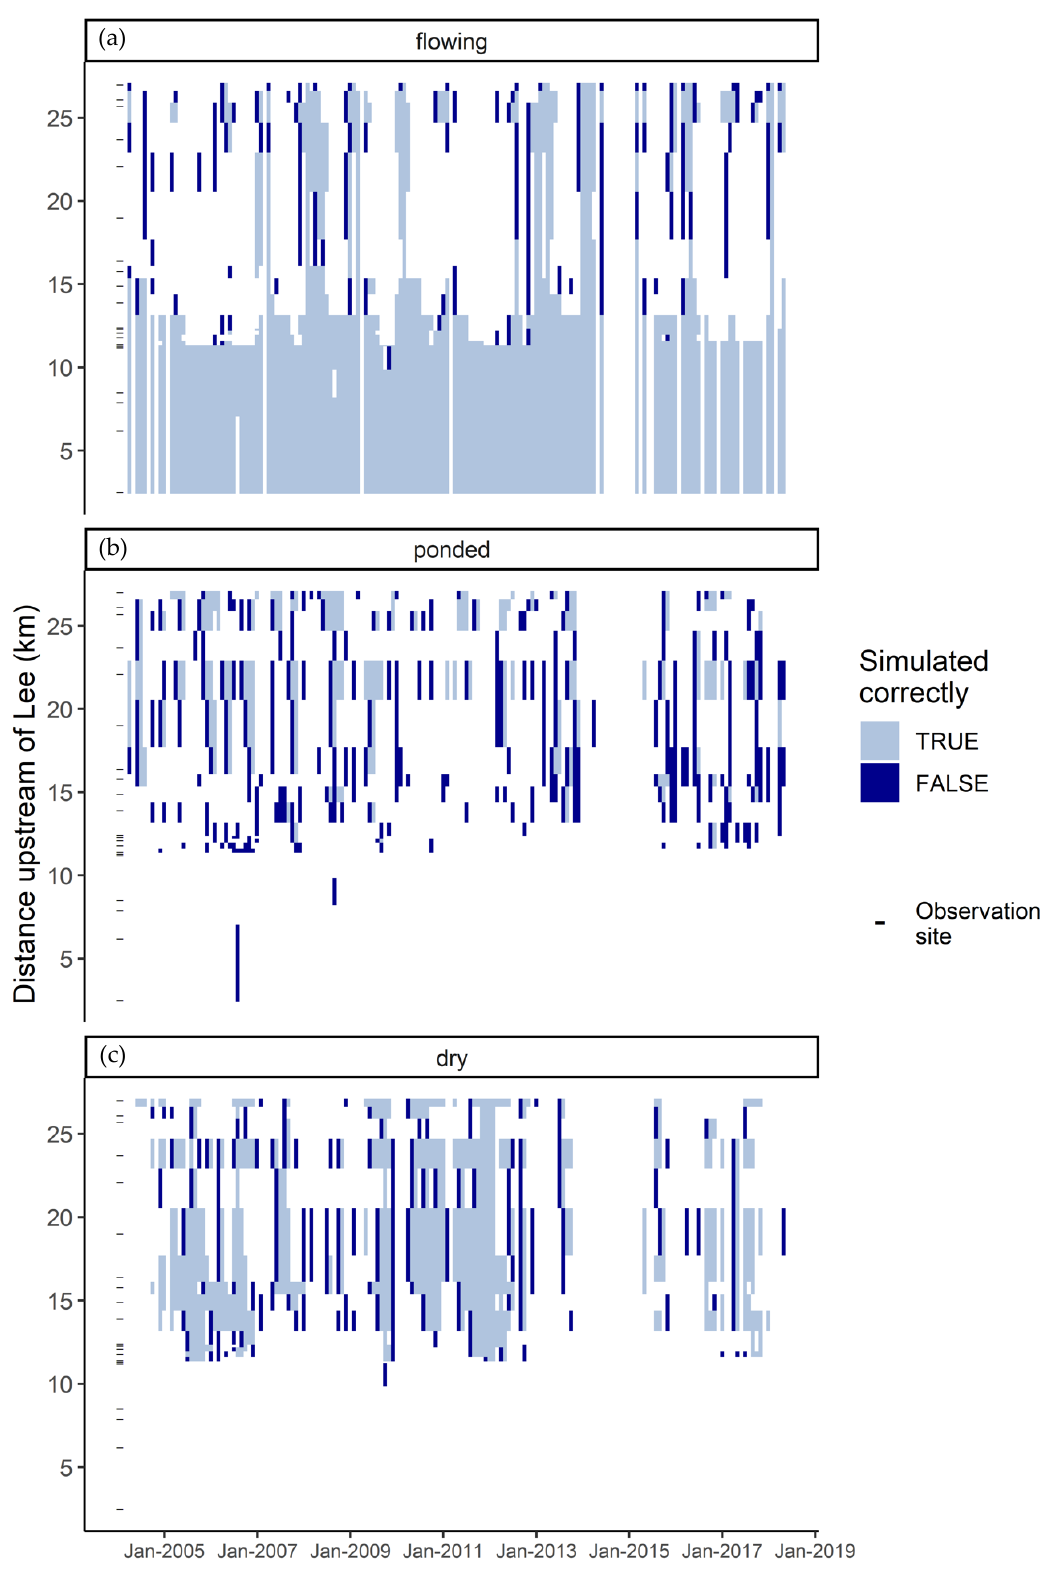
Figure 9. Monthly time series indicating whether flowing ( a ), ponded ( b ), and dry ( c ) states were simulated correctly and when and where the states were observed on the Ash. Hydrological state is assumed to be consistent along observed reaches due to the high spatial resolution of the data.